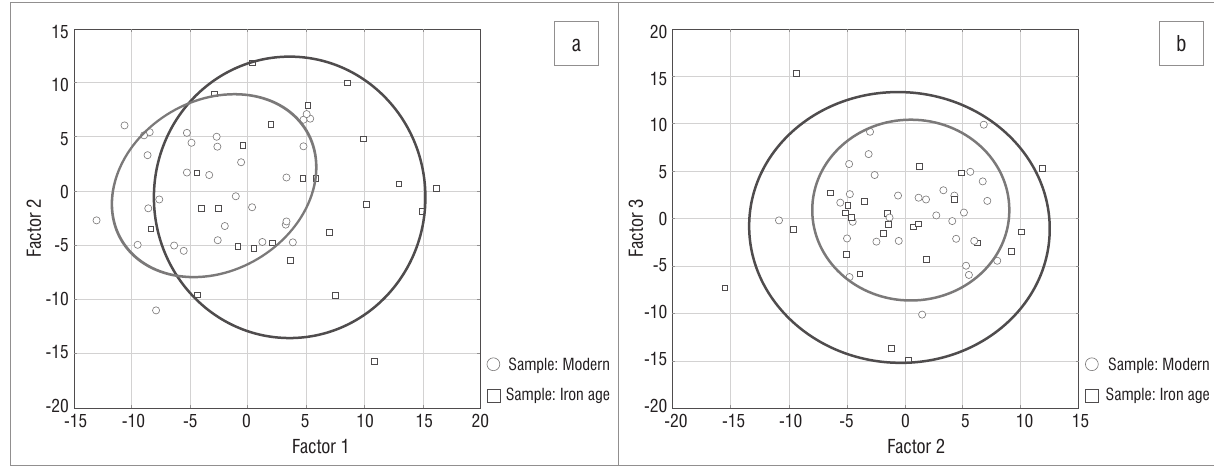
Figure 2: Principal components analysis of craniomandibular dental metric results: (a) scatterplot of factor 1 (27% variance) versus factor 2 (18% variance) and (b) factor 2 versus factor 3 (16%